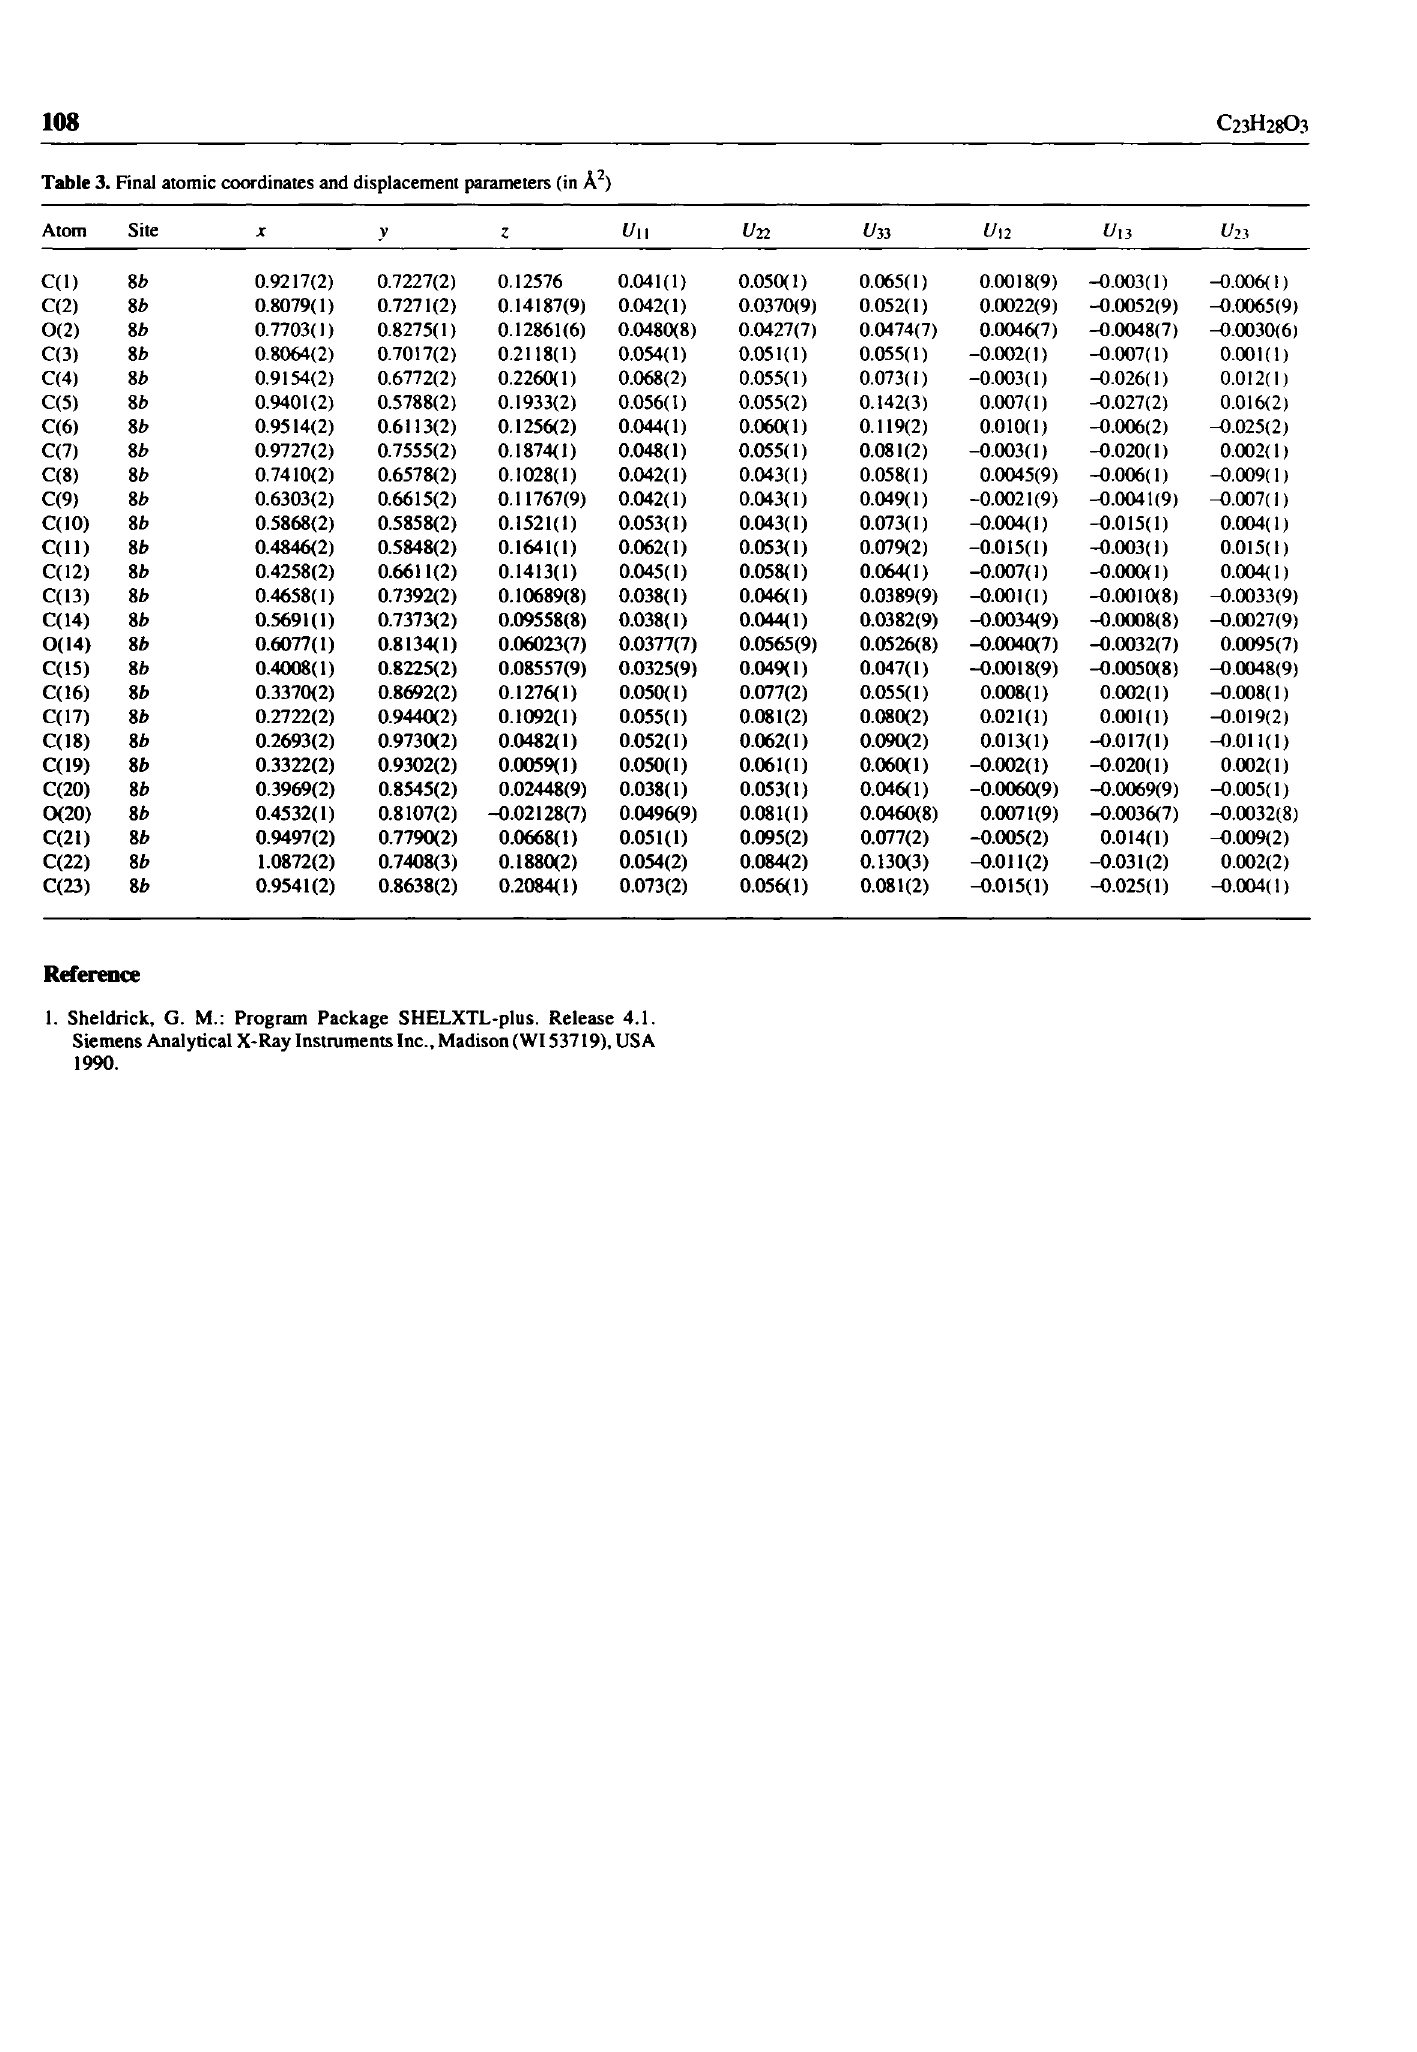
Table 3. Final atomic coordinates and displacement parameters (in